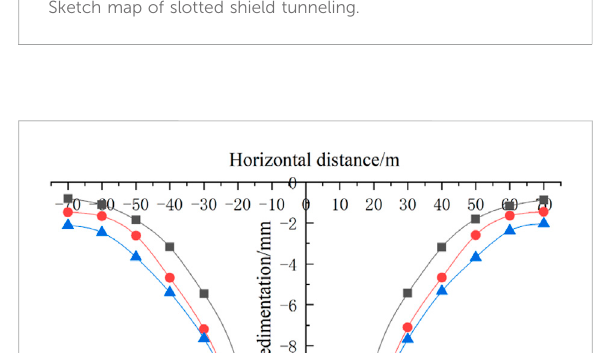
FIGURE 5 Construction sequence diagram of a slotted shield. FIGURE 6